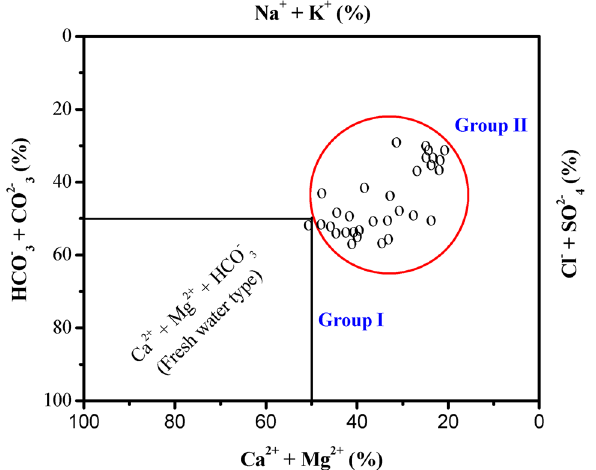
Fig. 4 Geochemical evolution (after Langelier and Ludwig 1942)